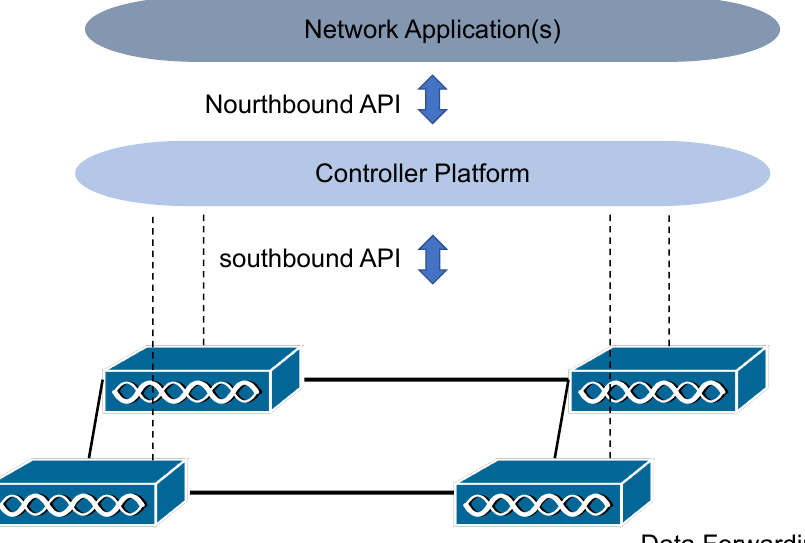
Figure 4. Software-Defined Network (SDN)